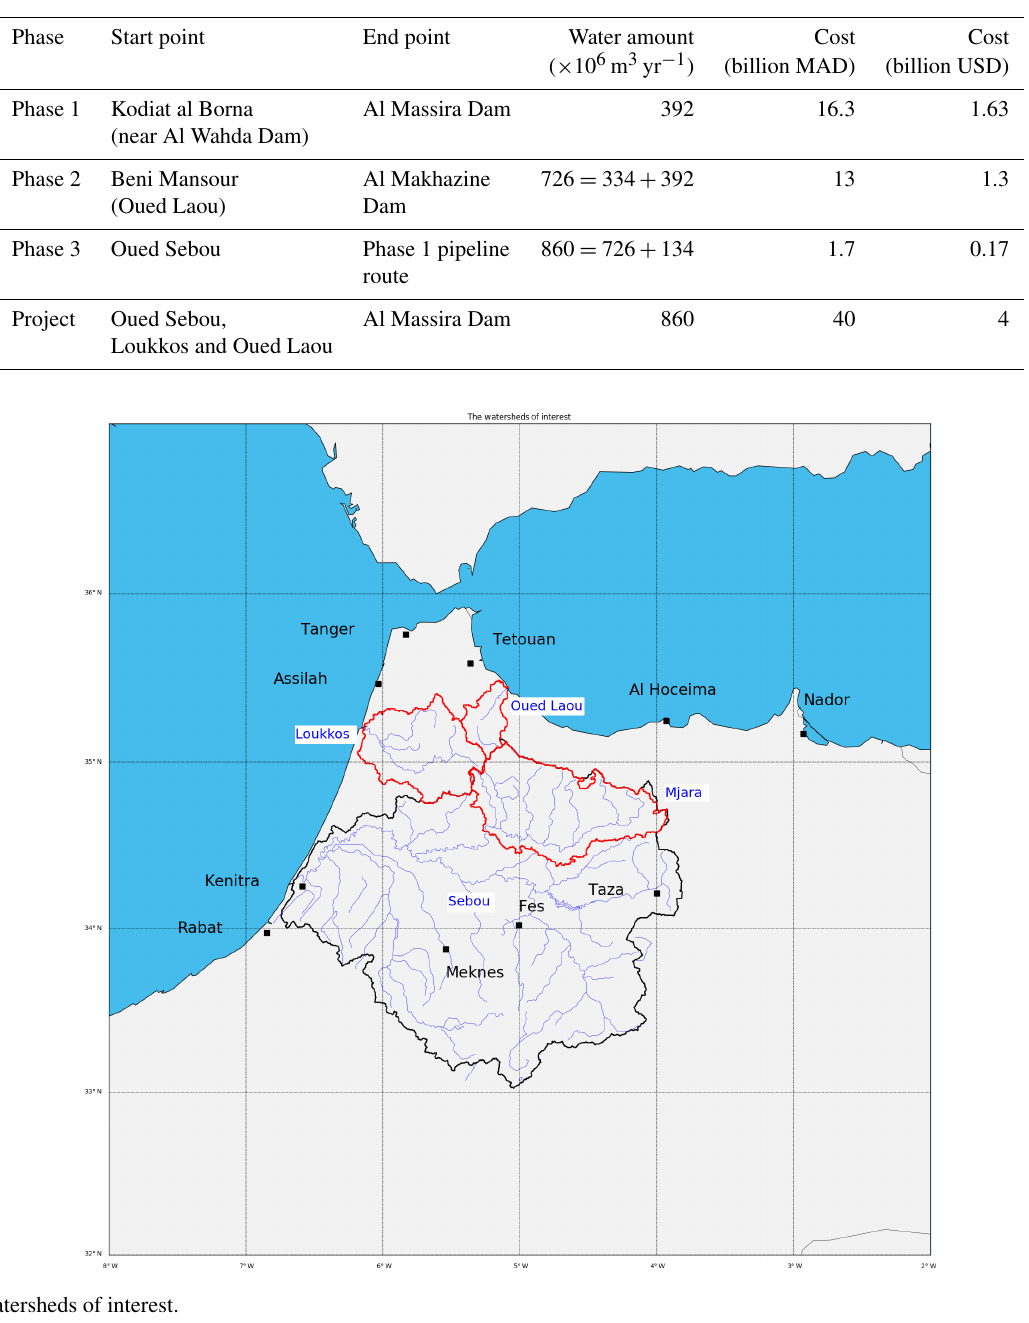
Table 1. The three phases of the project. These numbers are given as an indication, and the remaining amount of the budget will be dedicated to the rehabilitation of existing hydraulic infrastructures.